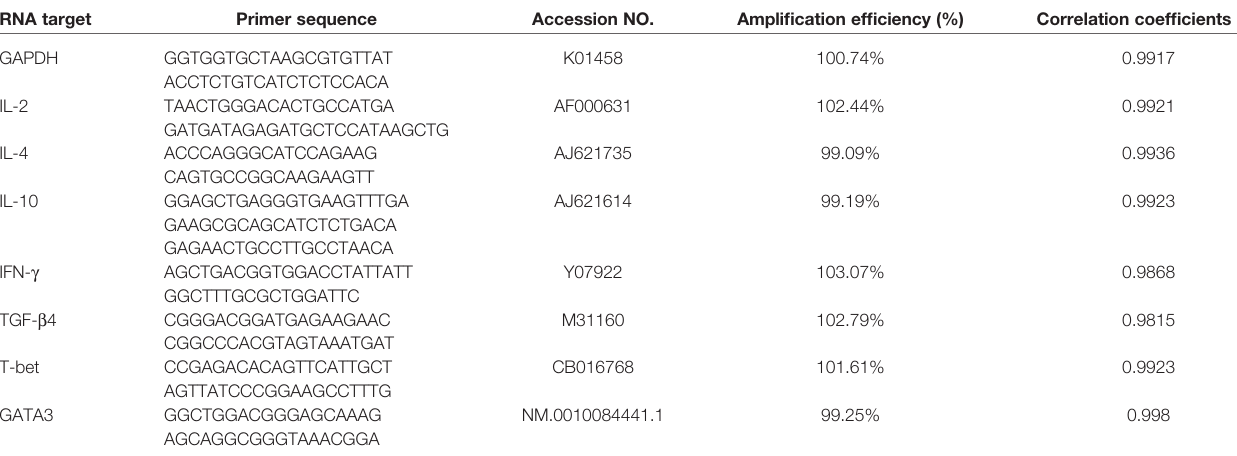
TABLE 1 | Sequence of the primers used in real-time quantitative